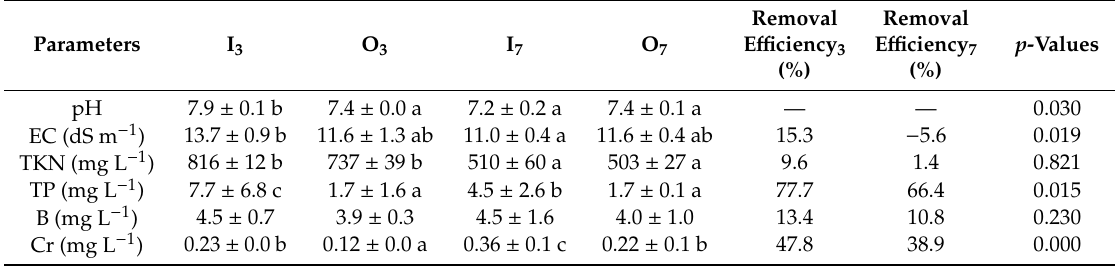
Table 2. Chemical composition of wastewater at the inlet and outlet of the CW, and removal e ffi ciencies for HRTs of 3 and 7 days.